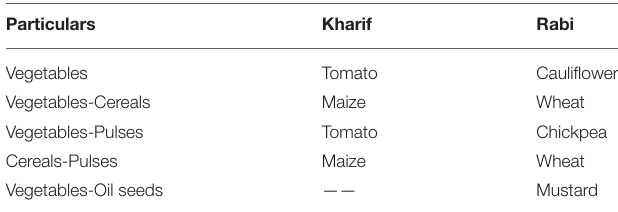
TABLE 8 | Season-wise major crop combinations under conventional farming (CF)